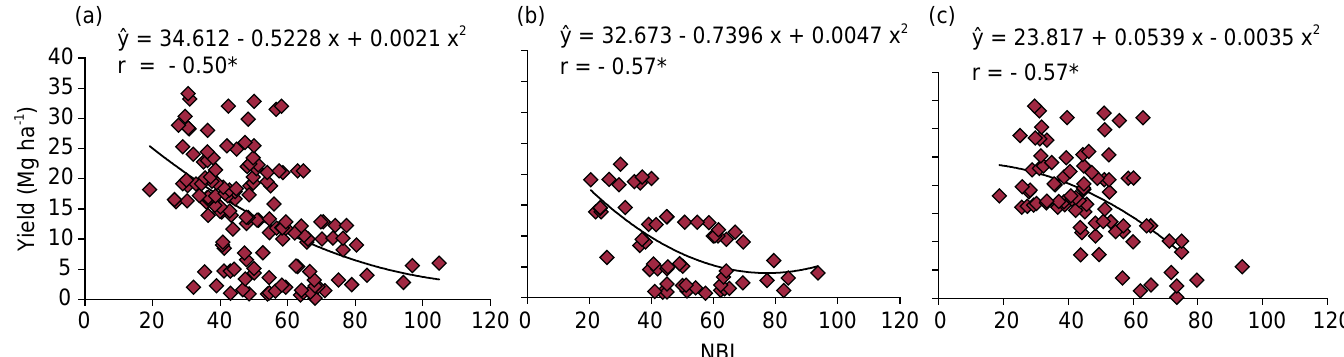
Figure 2. Relationship between nutritional balance indices (NBI) and yields of oil palm stands considering DRIS norms composed by oil palms of all ages (a), young palms (≤6 years) (b), and adult palms (>6 years) (c) in the state of Pará, Brazil. *: significant (p<0.05) by Student’s t test.